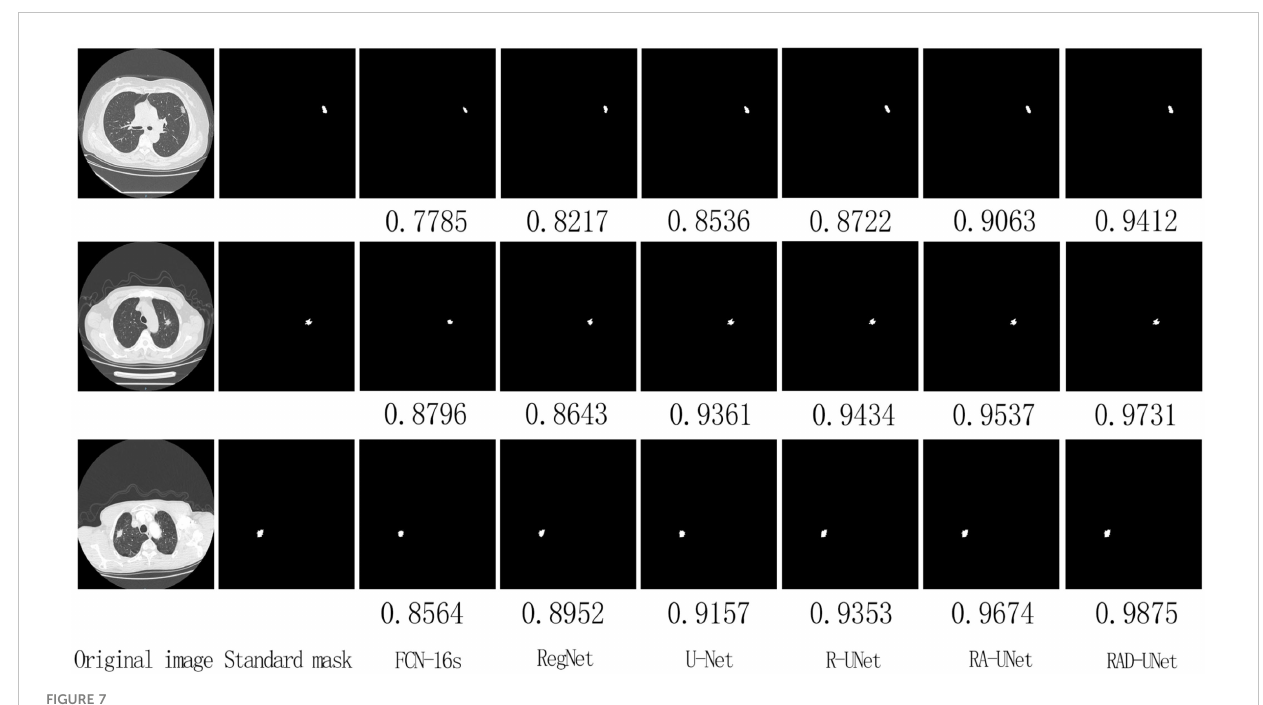
FIGURE 7 Comparison of lung nodule segmentation results on the AHAMU-LC dataset.